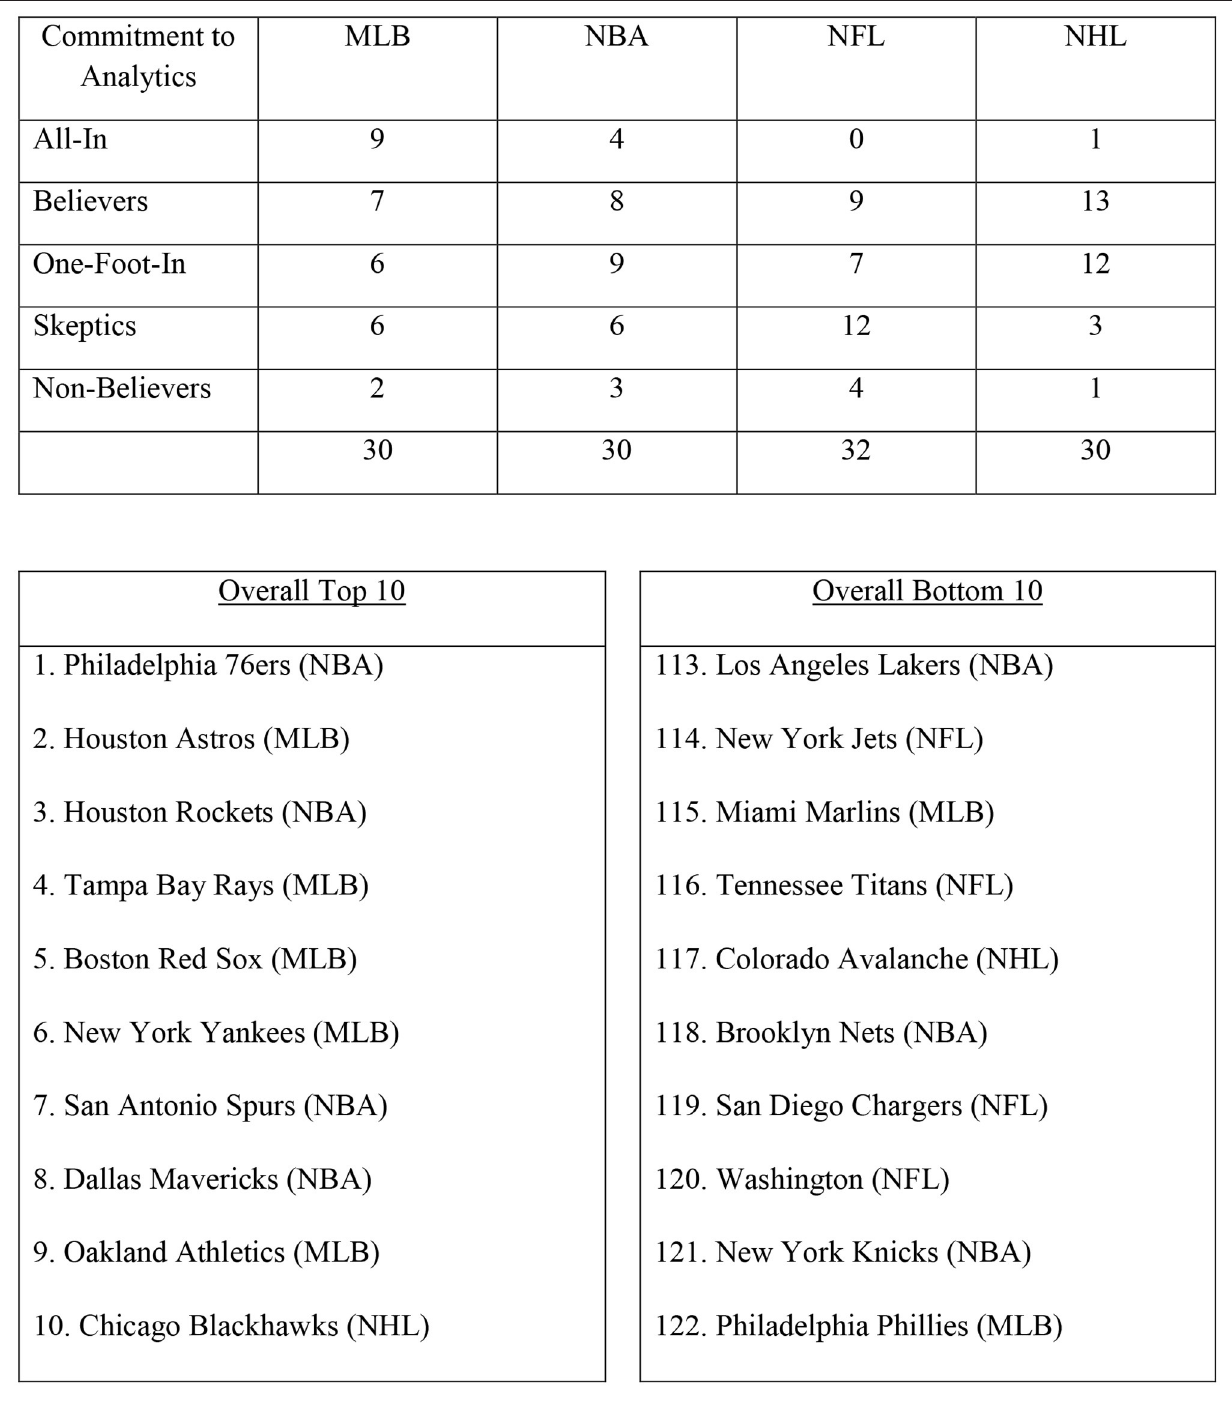
FIGURE 4 | Analytics rankings of North American clubs in the MLB, NBA, NFL, and NHL by ESPN The Magazine in 2015.